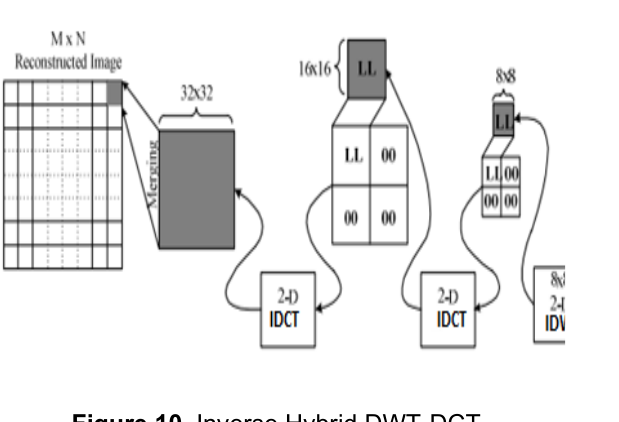
Figure 10. Inverse Hybrid DWT-DCT Algorithm